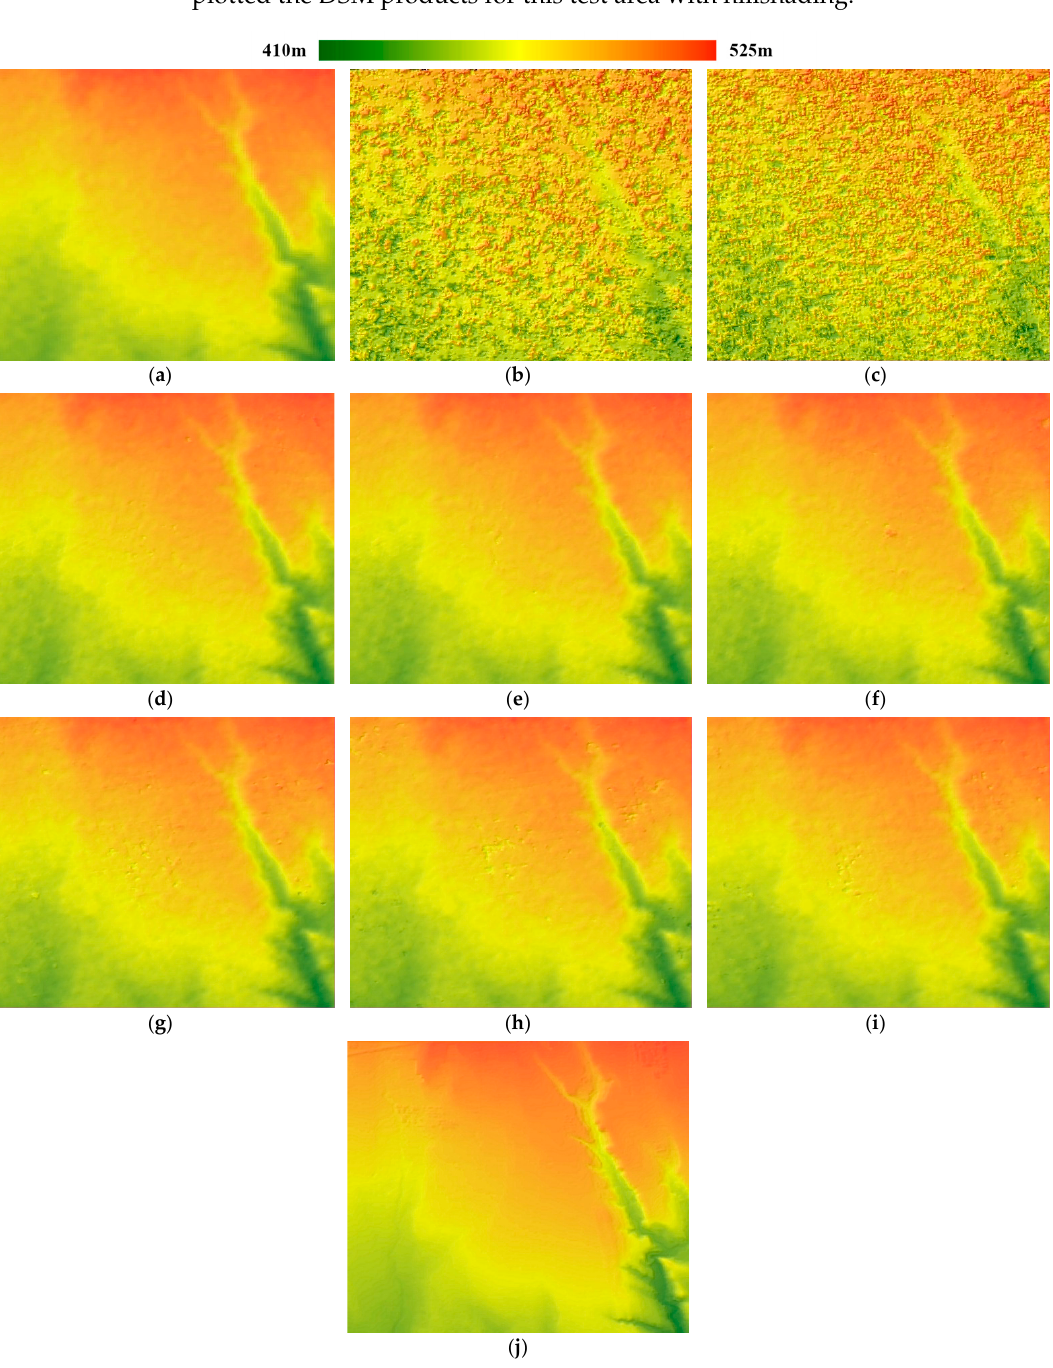
Figure 10. Hillshade of test area 3: ( a – c ) Hillshade of SRTM DEM, SL mode DSM by NCC, and SM mode DSM by NCC; ( d – f ) Hillshade of SL mode DSMs by SGM_const, SGM_gray, and SGM_canny; ( g – i ) Hillshade of SM mode DSMs by SGM_const, SGM_gray, and SGM_canny, and ( j ) Hillshade of reference